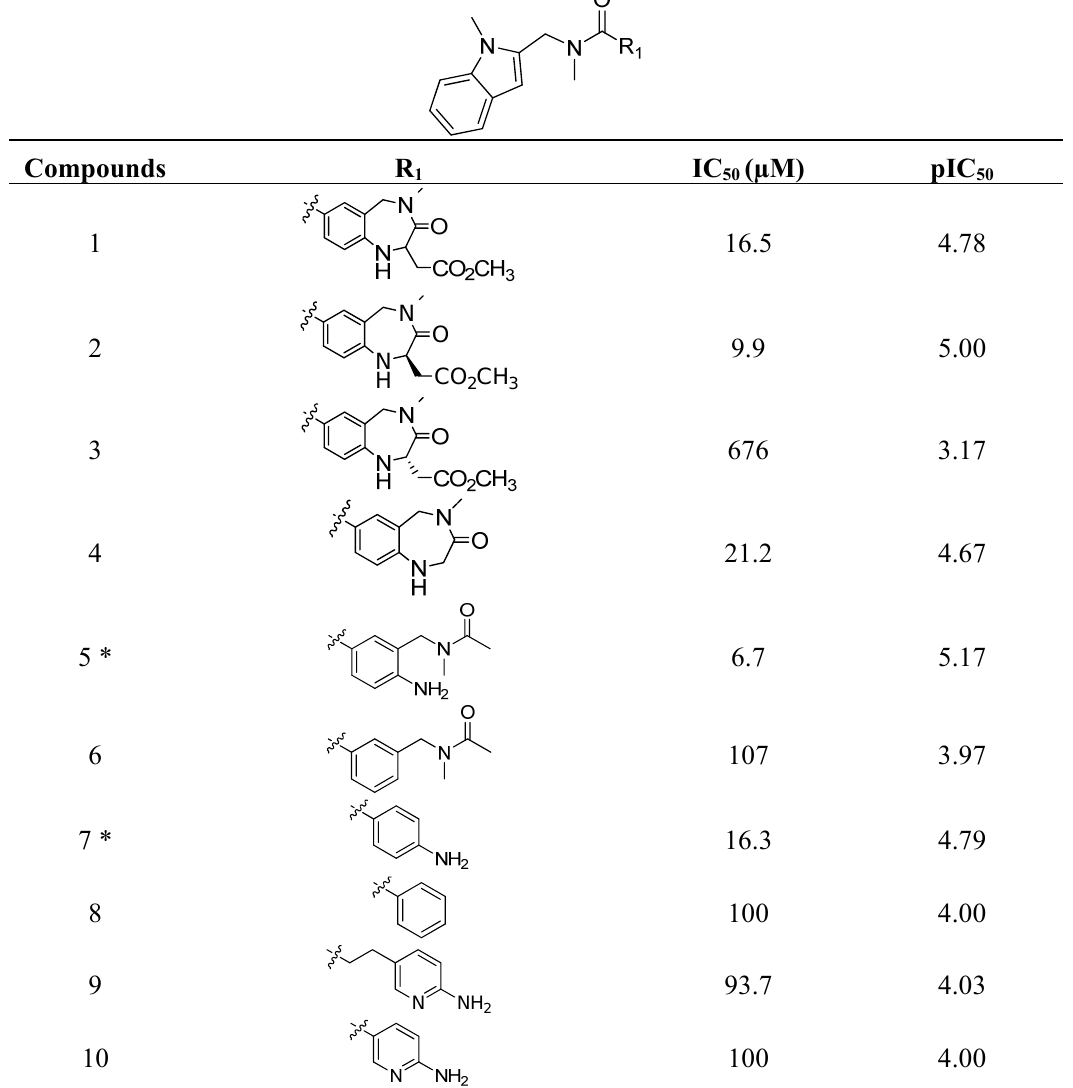
Table 1. Structures, activities and experimental pIC training and test sets. The test set compounds are marked by an asterisk